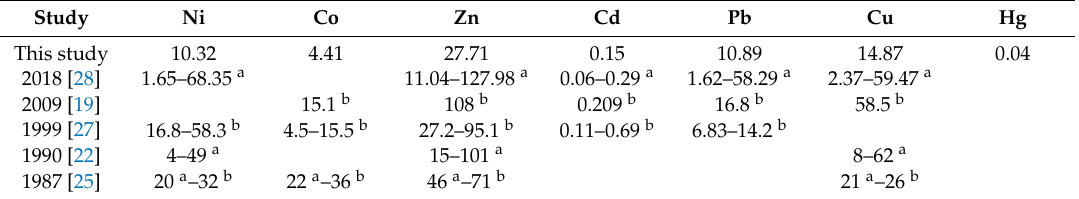
Table 5. A comparative account of metal concentration (in mg / Kg) measured in previous studies using sediments located in the same area than that showed in the current